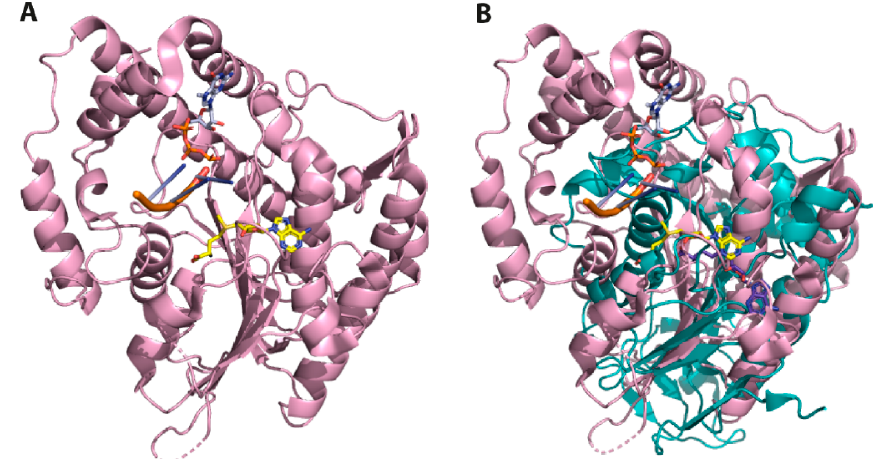
Figure 6. Superposition of the 3D structures of SARS-CoV-2 and human 2 ′ O-MTase. ( A ) Ribbon representation of human 2 ′ O-MTase (magenta) in complex with SAM (yellow) and RNA (orange). ( B ) The superposition of SARS-CoV-2 (teal) and human 2 ′ O-MTase (magenta) reveals substantial differences in their topology. The structures correspond to the PDB IDs 6WKQ and 4N48, respectively.